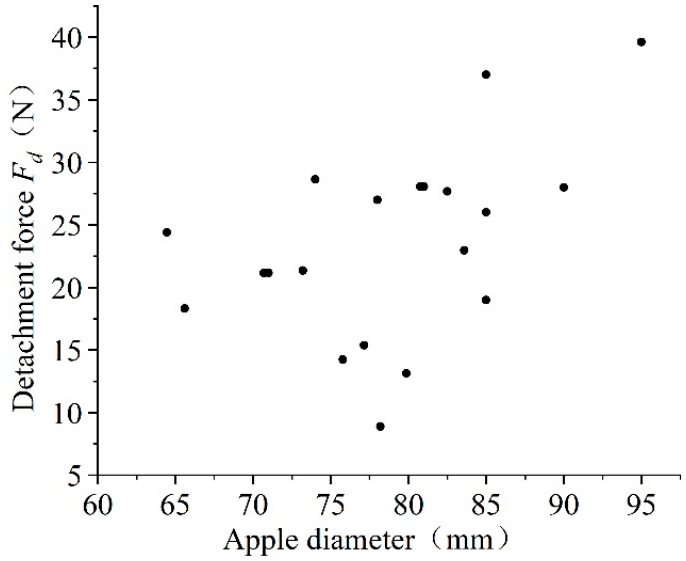
Figure 17. The experiment used twenty apple samples with diameters ranging from 65 mm to 95 mm.